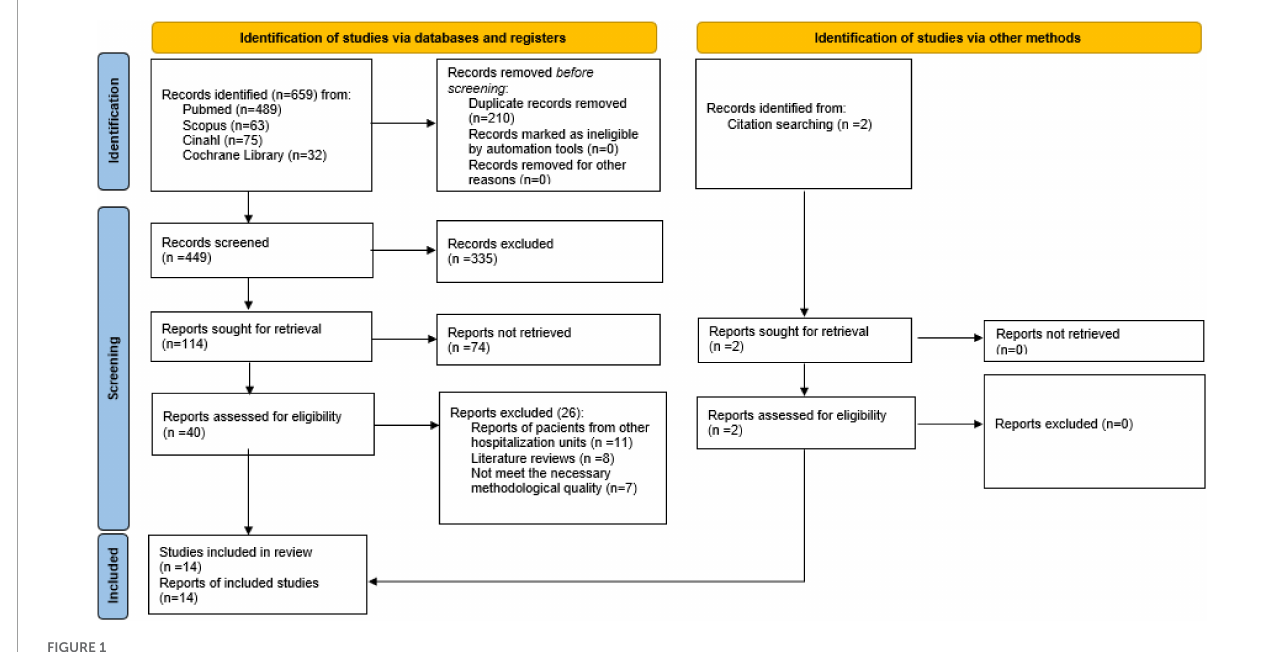
FIGURE1 Selection process flow chart (PRISMA